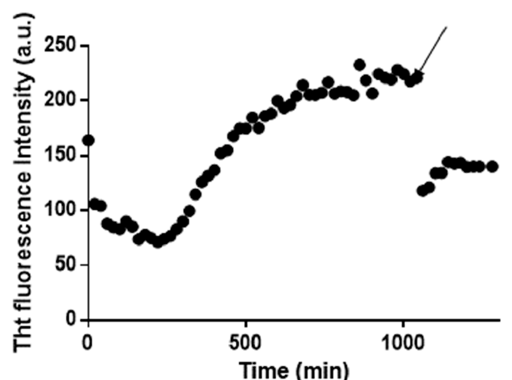
Figure 5. The ThT fluorescence profile of the formation of amyloid aggregates of A β 21–40 and their disaggregation upon the addition of 1 at 1:1 peptide to Pt compound molar ratio. The time of addition of the Pt(II) compound is indicated by an arrow.